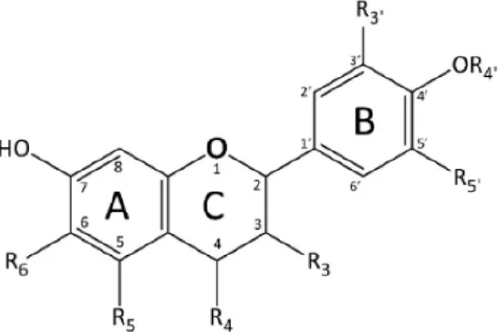
Figure 5. The basic structure of flavonoids. A and B —benzene rings; C —closed pyran ring. Most flavonoids are transformed in the small intestine before being absorbed. Alt-